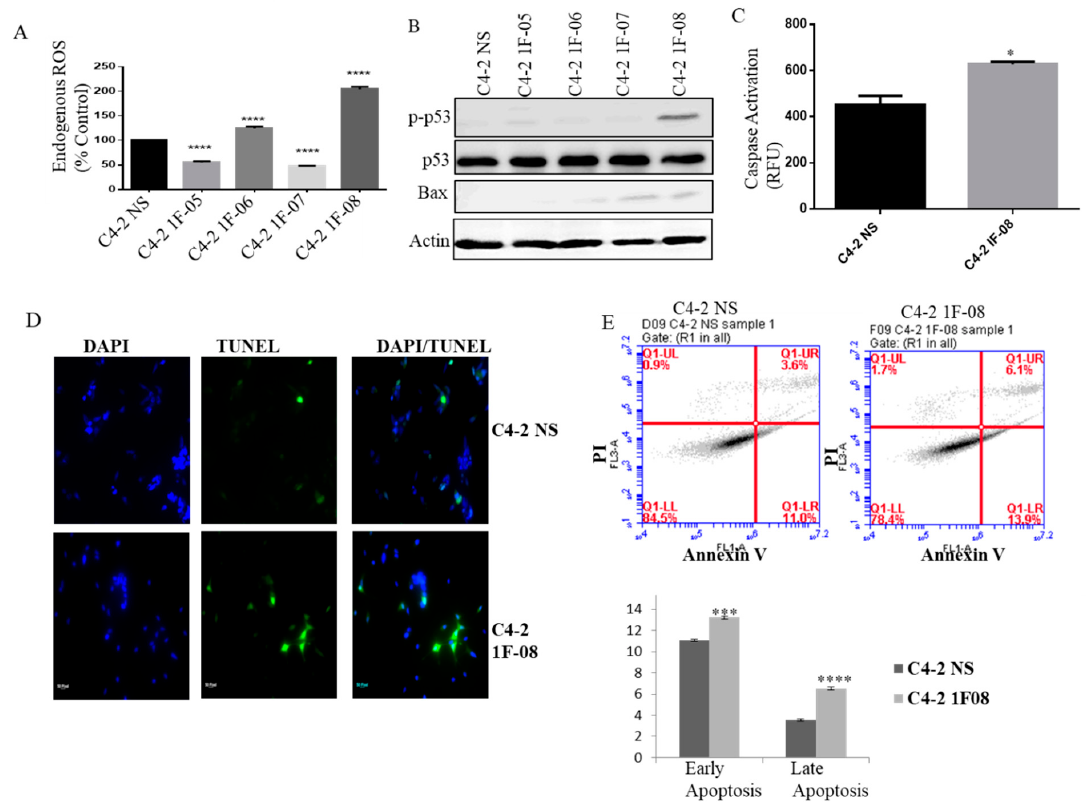
Figure 3. PXDN scavenges ROS and inhibits apoptosis. ( A ) ROS assay was performed to detect H 2 O 2 in PXDN knockdown cells using ROS detection reagent CM-DCFDA for 1 h at 37 ◦ C. 1 × 10 4 cells per well were plated in a black walled 96-well plate and read in a spectrophotometer with excitation at 485nm and emission at 535 nm. ( B ) Western blot analysis was performed on PXDN cells to probe for pro-apoptosis related proteins p53 and Bax. Actin was utilized as a loading control. ( C ) MitoCasp assay was performed to look at caspase-3 / 7 activity. ( D ) TUNEL assay (magnification at 20 × ) was performed to detect apoptosis using the In Situ Cell Death Detection Kit. ( E ) The cells were stained with Annexin V- Alexa Fluor 488 and PI and analyzed by Flow cytometry. Values were normalized to C4-2 NS and the mean ± SEM of data were obtained from three independent replicate experiments. Statistical analysis was done with GraphPad Prism; (* p < 0.5, *** p < 0.001, **** p < 0.0001).